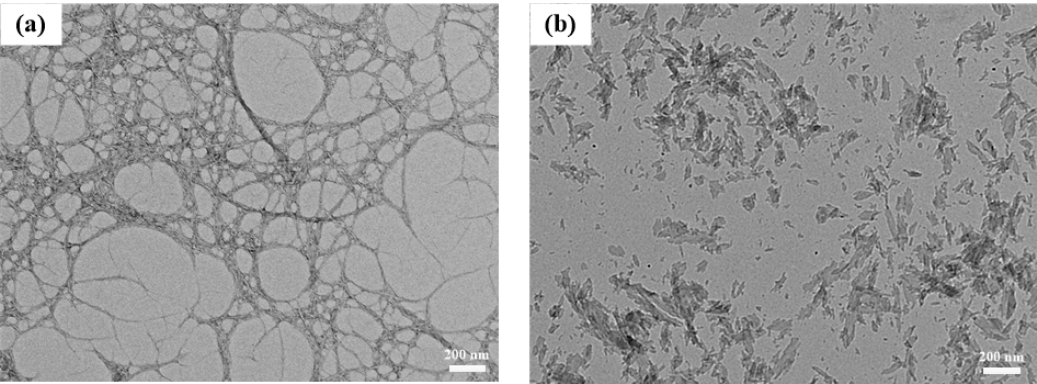
Figure 1. TEM images of ( a ) cellulose nanofibrils (CNFs) and ( b ) nano-aluminum nitride (AlN).